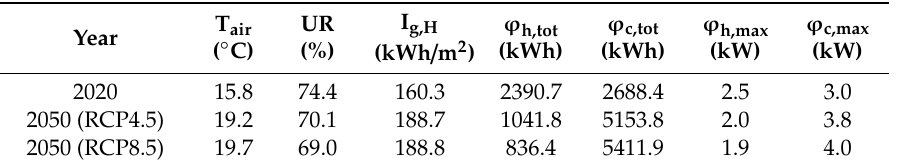
Table 4. Air temperature (T air ), relative humidity (UR), horizontal global solar irradiance (I g,H ) , heating energy needs ( ϕ h,tot ), cooling energy needs ( ϕ c,tot ), peak power for heating ( ϕ h,max ) and peak power for cooling ( ϕ c,max ) for the three analyzed